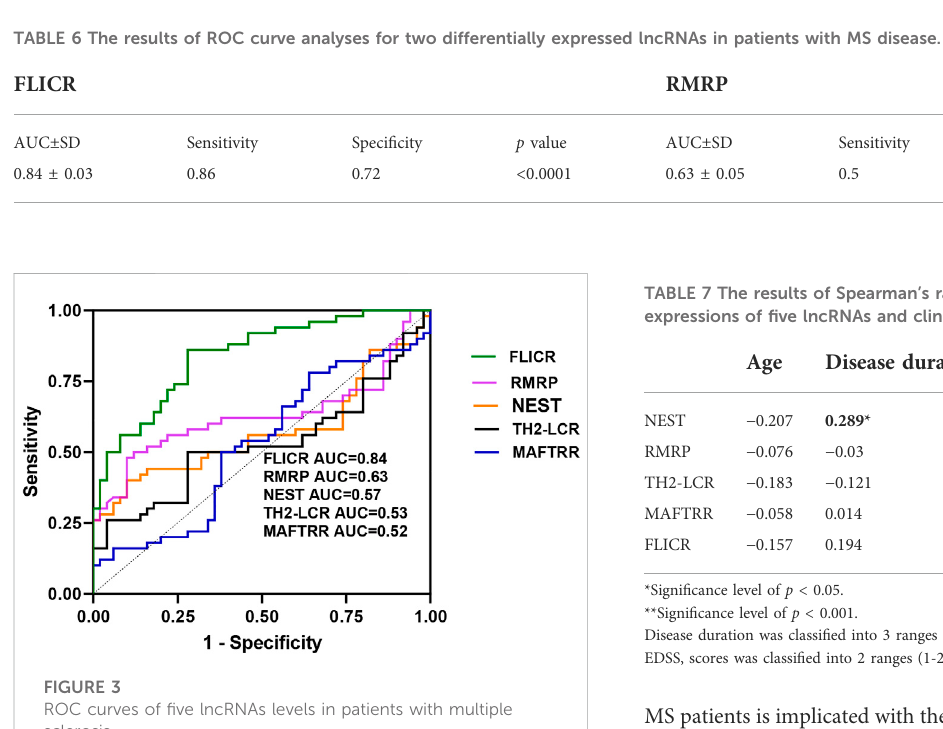
FIGURE 3 ROC curves of fi ve lncRNAs levels in patients with multiple sclerosis.